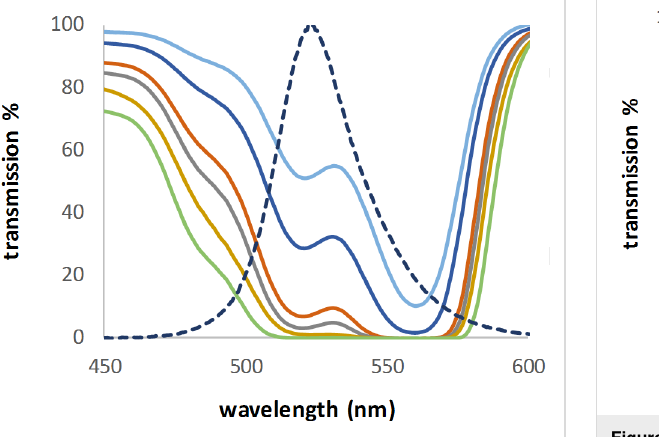
Figure 4: Transmission spectra of rose bengal ( D ) and the emission spectrum of an LED with a maximum at 524 nm (scaled to 100%).